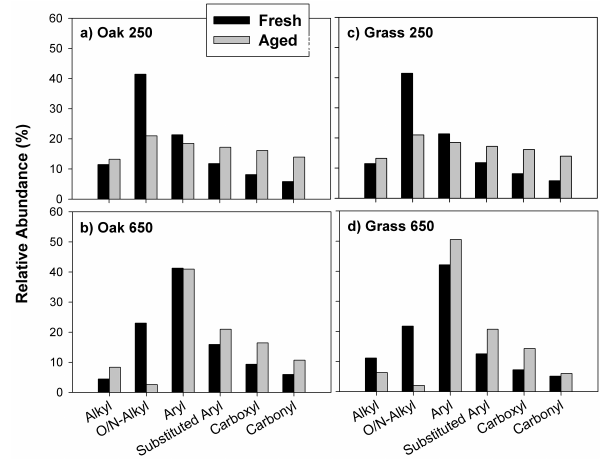
Figure 3. Relative functional group distributions determined by 13 C CP-MAS NMR for fresh and aged (a) oak-250, (b) oak-650, (c) grass-250 and (d) grass-650 biochars.